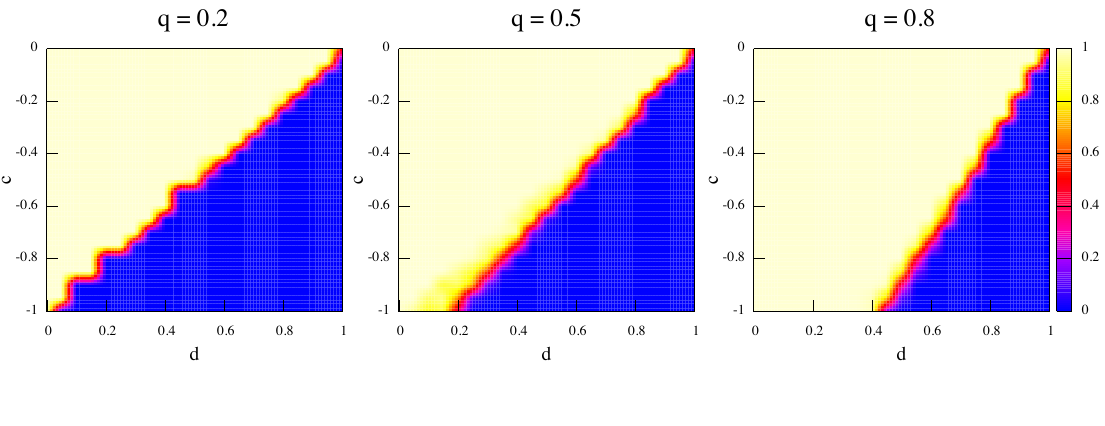
Figure 6. Average strategy proportions over 50 independent runs in the game’s phase space at steady state. Initially α and β are equally represented. Update rule is best response and rewiring frequency q increases from left to right.